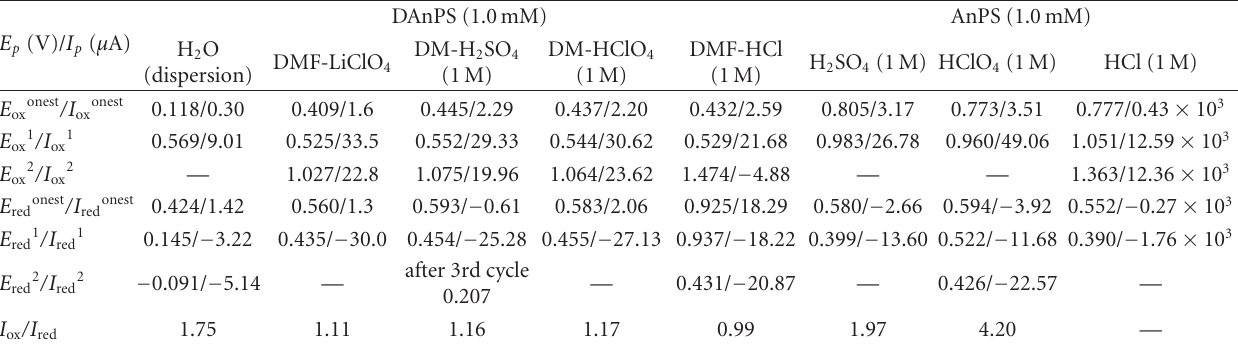
Table 1: Cyclic voltammetry data of DAnPS and AnPS recorded at Pt electrode in di ff erent electrolyte media. E I μ A) p (V)/ p (